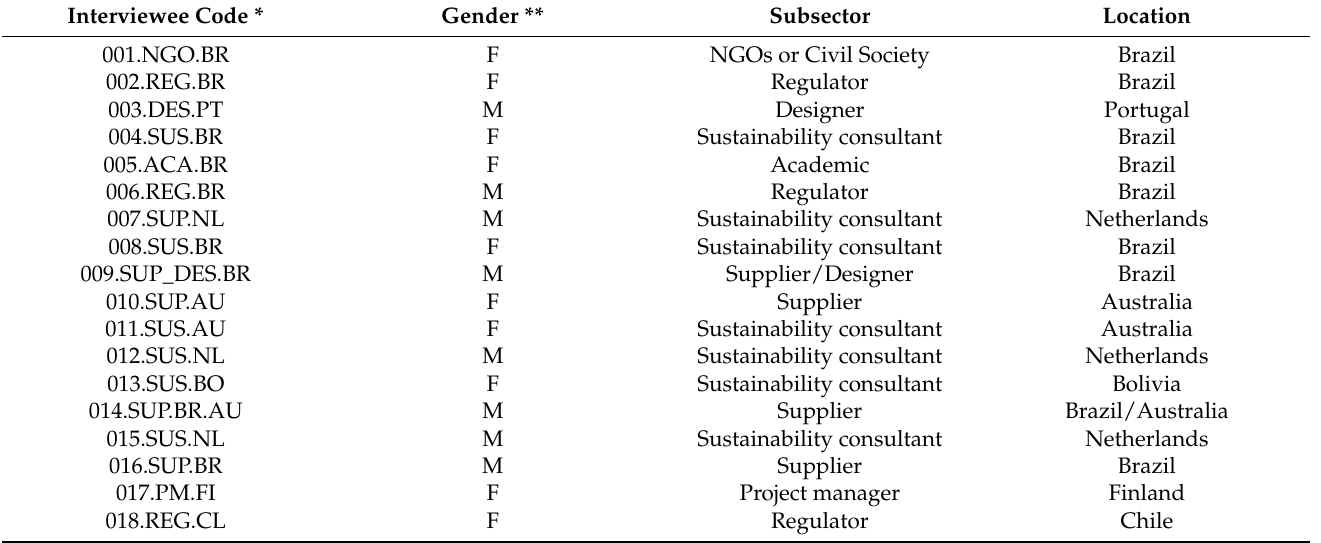
Table 2. Profile of